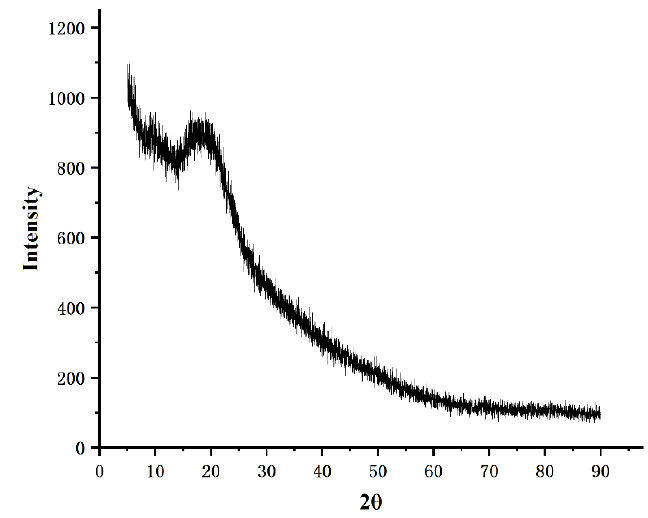
Figure 7. X-ray diffraction pattern of PF40.